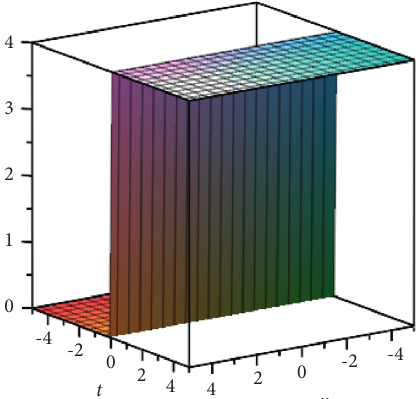
( x,t )| when a � 1 , f � 2 ,k � − 1within theinterval − 2 ≤ x ≤ 0 , − 5 ≤ t ≤ 5. 18 1